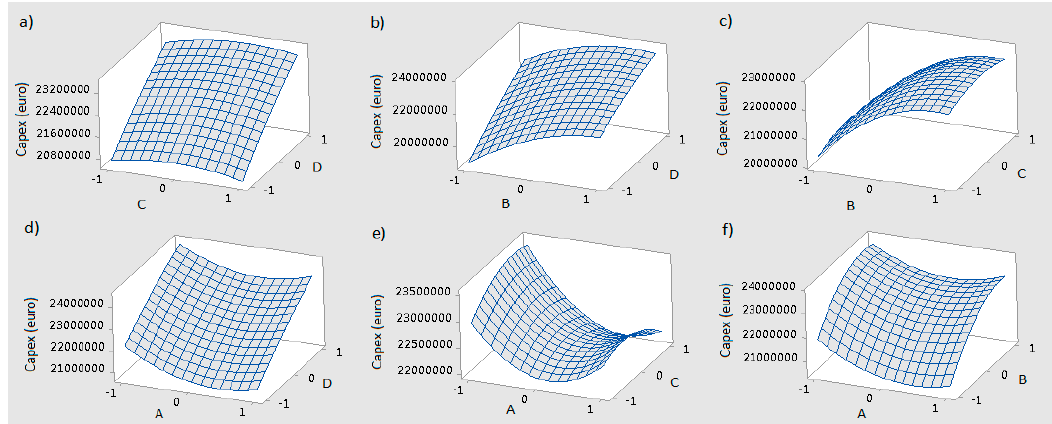
Figure 5. Response surface plots for CAPEX (€) as a function of: ( a ) factor C and D ; ( b ) factor B and D ; ( c ) factor B and C ; ( d ) factor A and D ; ( e ) factor A and C ; ( f ) factor A and B (Hold values: A = B = C = D = 0) (factor A = flue gas inlet temperature, factor B = column pressure, factor C = carbon dioxide composition in flue gas, factor D = height of the absorber).